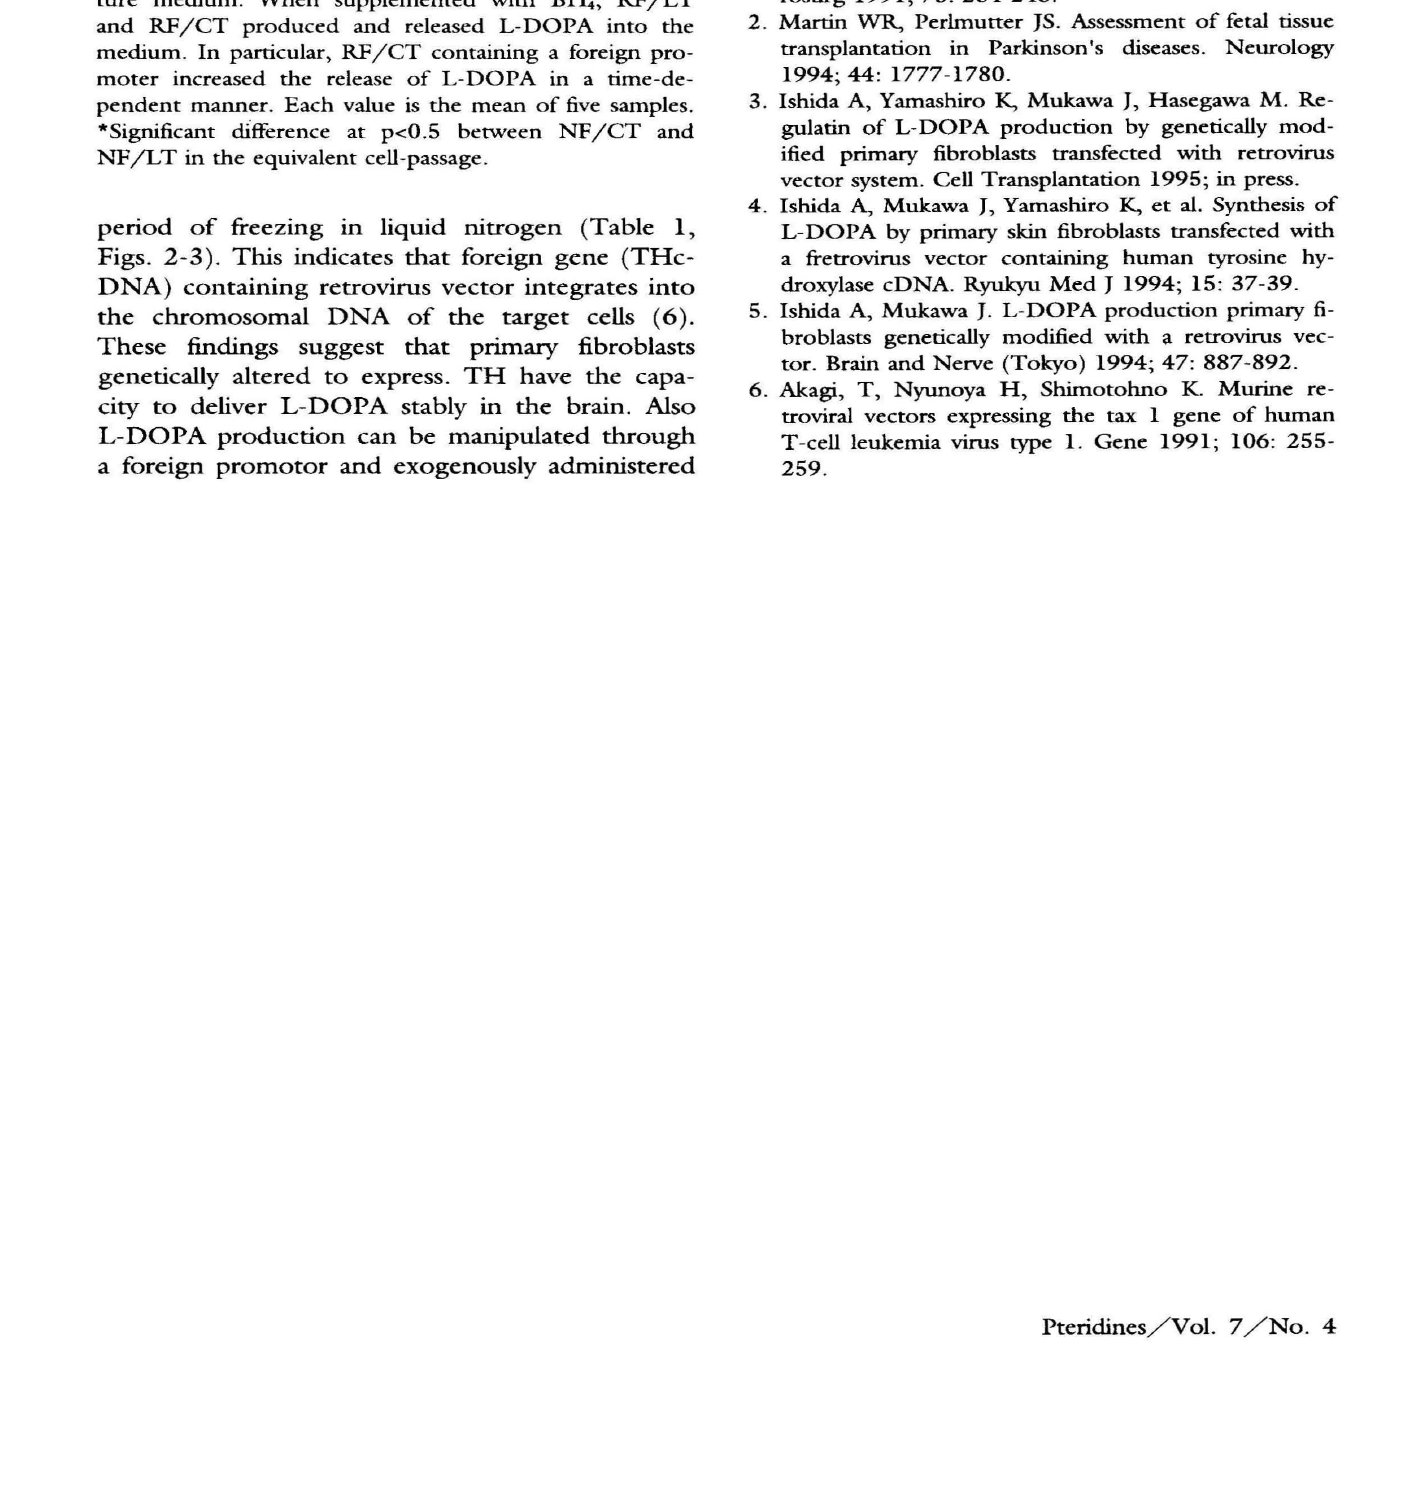
Figure 3. L-DOPA production and release into the cul ture medium. When supplemented with B~, RF /L T and RF/CT produced and released L-DOPA into the medium. In particular, RF/ CT containing a foreign pro moter increased the release of L-DOPA in a time-de pendent manner. Each value is the mean of five samples. *Significant dlfference at p<O.S between NF /CT and NF/LT in the equivalent cell-passage.